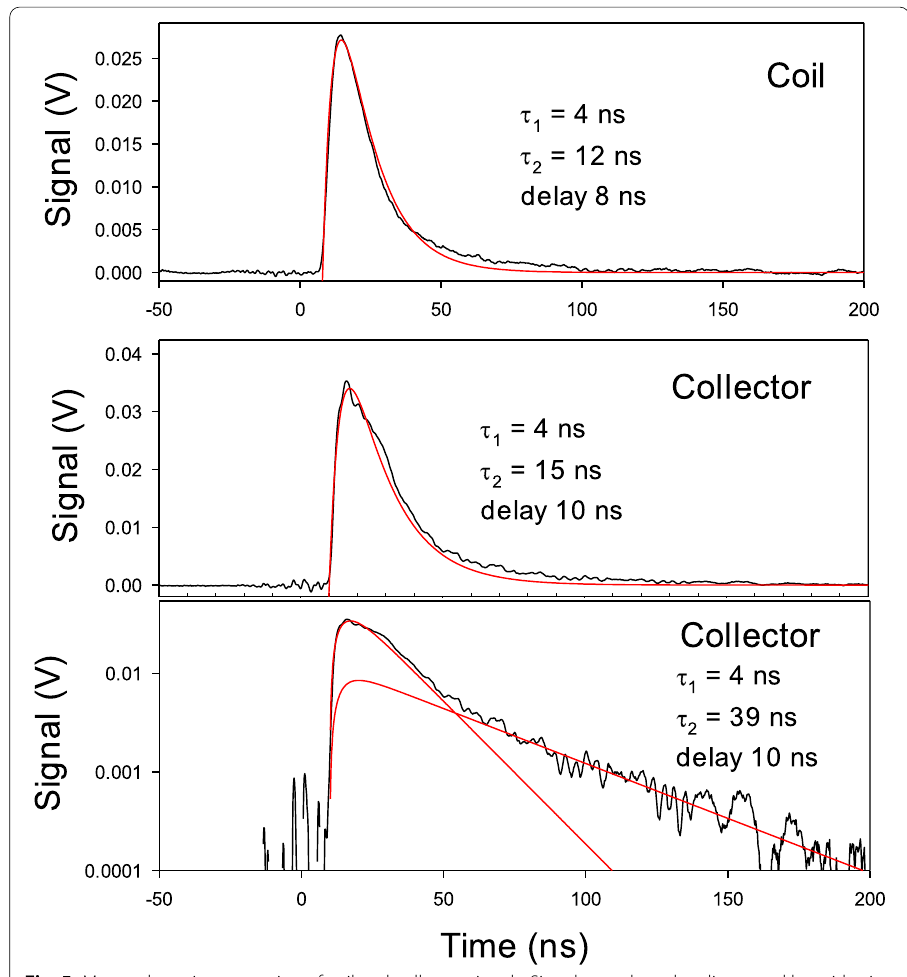
Fig. 5 Meson decay interpretation of coil and collector signals. Signals are plotted on linear and logarithmic vertical scales. Calculated curves from Eq. (5) are in red with time constants shown. The decay time constants used are for decay of the intermediate kaons and pions. In the bottom panel, two calculated curves are included in the log plot. The values given in this panel are for the adjacent curve. The formation time constant τ 1 is likely caused by the laser pulse width of 5 ns. The delays are given relative to the photodiode trigger from the laser pulse. The time constant of 39 ns is a dilated pion decay for pions formed by kaon decay, moving at a relativistic velocity of approximately 0.75 c . See further Ref. [33] for details on the velocity